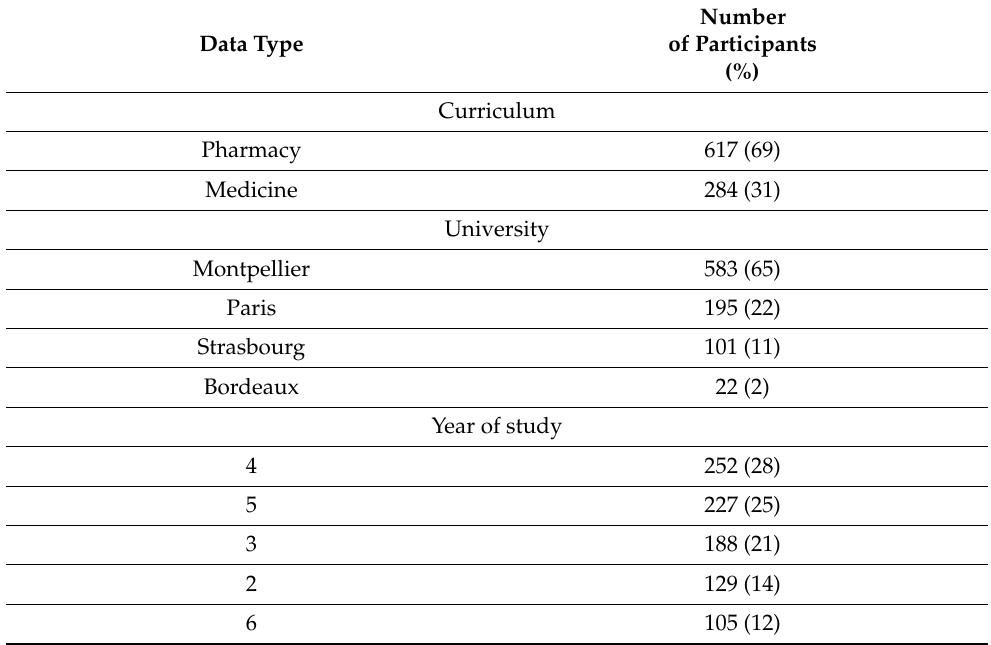
Table 2. Demographics of study participants (n = 901).